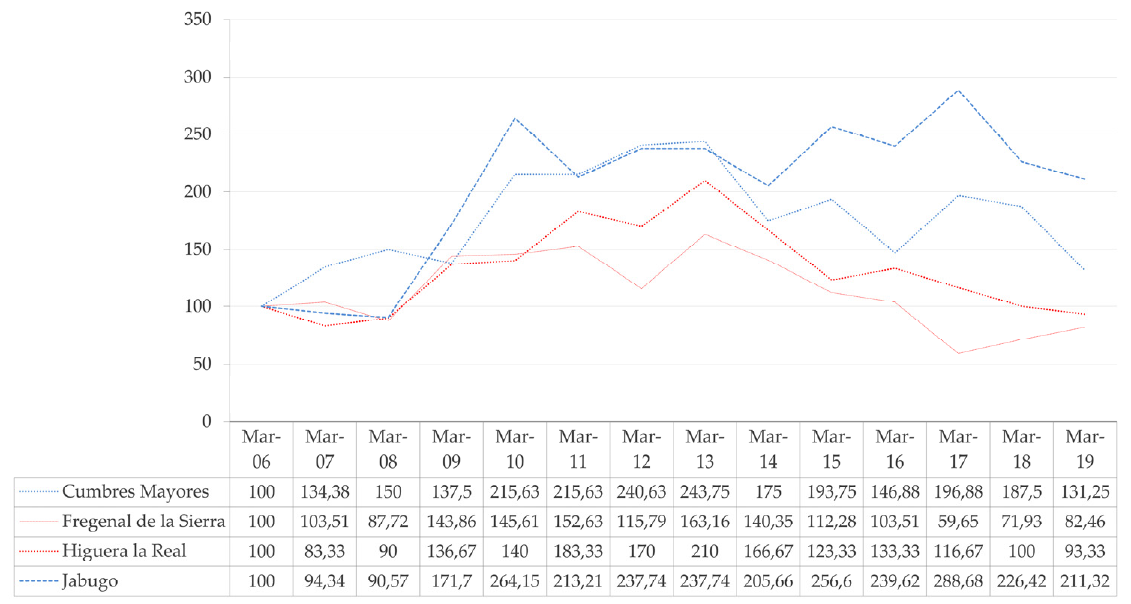
Figure 14. Female unemployment registered in the LPS-IPTI (index 100 = March 2006). Source: [101]. Authors own elaboration.